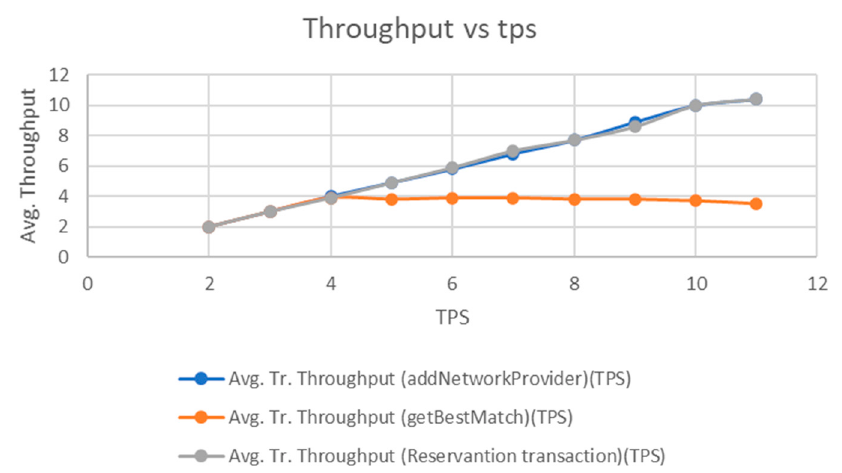
Figure 3. The throughput per smart contract function.